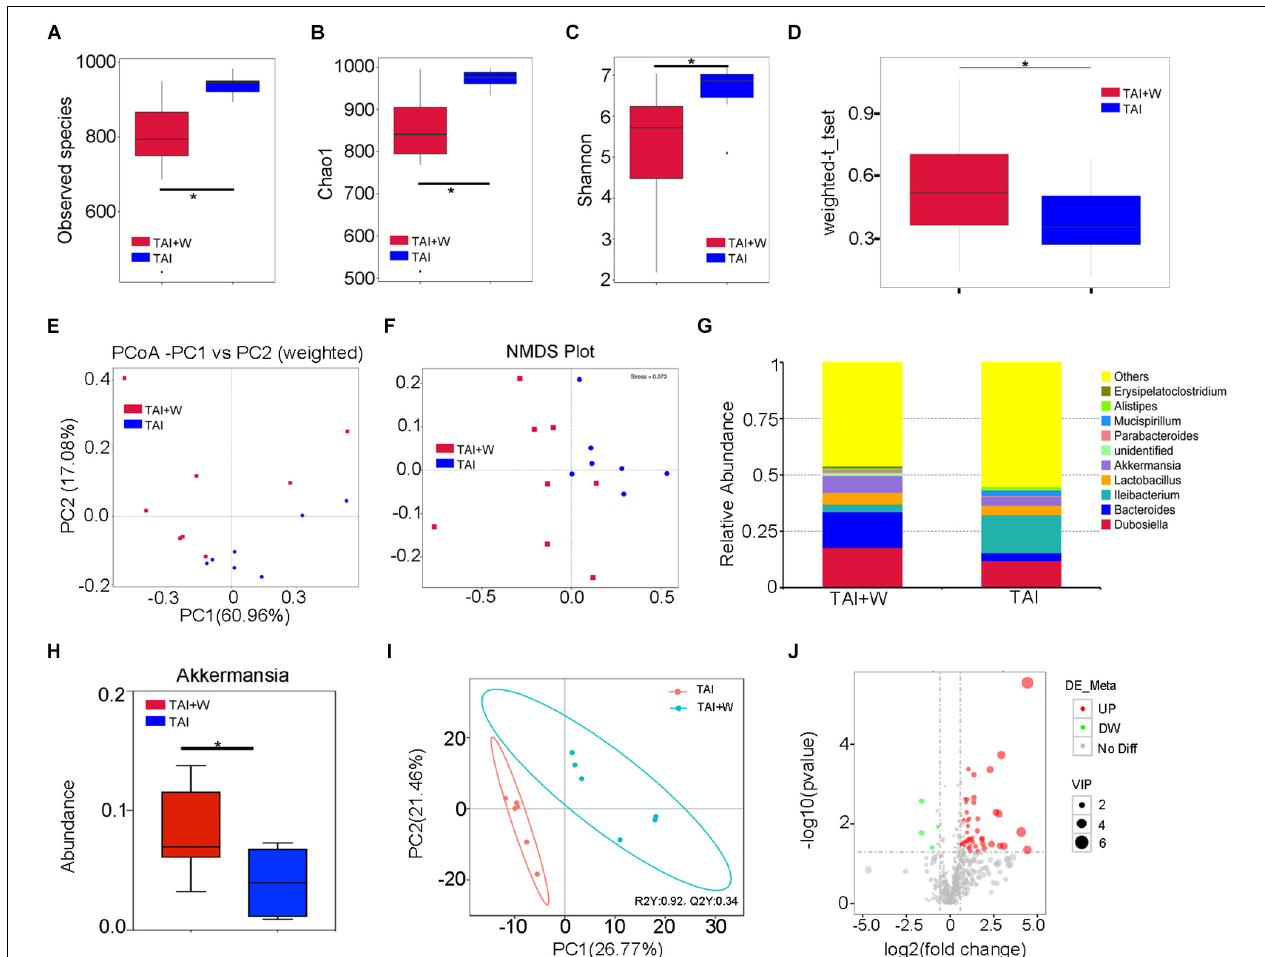
FIGURE 2 | Walking reshapes gut microbiota configuration following radiation challenge. The gut bacterial composition structures in male mice of TAI (radiation alone) and TAI + W (walking after radiation) groups were measured by 16S rRNA high-throughput sequencing at 16 days following TAI exposure, n = 7 (TAI group) or n = 8 (TAI + W groups). The gut metabolite composition was detected by untargeted metabolomics at 16 days following TAI exposure, n = 6 (TAI group) or n = 6 (TAI + W groups). (A–C) Alpha diversity was measured: (A) the observed species number, (B) Chao1 diversity index, and (C) Shannon diversity index. (D) The beta diversity of intestinal bacteria was compared by weighted t -test analysis. (E,F) PCoA (weighted) and NMDS were performed to assess the alteration of gut bacteria taxonomic profile from male mice in two groups. (G) The relative abundances of the top 10 varied strain bacteria at the genus level in male mice of two groups. (H) The abundance of Akkermansia in male mice of two groups. (I) The PLSDA score of positive metabolites in feces in the two groups. (J) The volcano diagram of positive metabolites in feces. (A–C) Significant differences are indicated: Wilcoxon rank sum test. (D,H) Significant differences are indicated: * p < 0.05 by Student’s t -test between two cohorts. TAI, total abdominal irradiation; W, walking; PCoA, principal coordinates analysis; NMDS, non-metric multidimensional scaling; PLSDA, partial least-squares discriminant